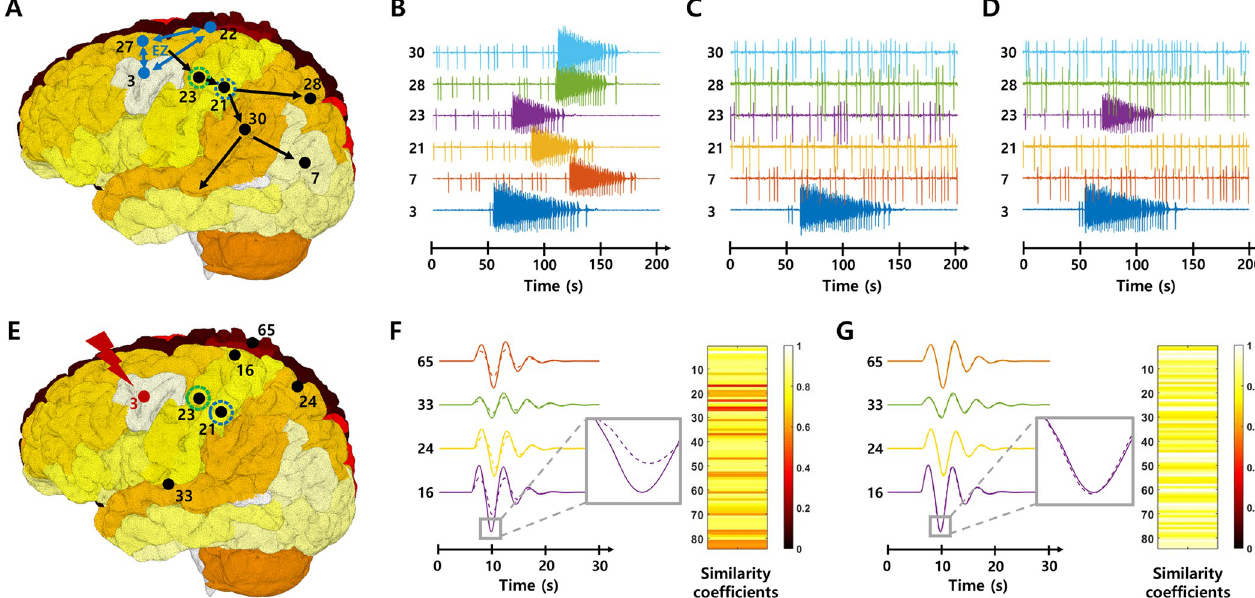
Fig 1. Brain network simulations using TVB. A-D Network simulations for the effectiveness evaluation. The brain network model assesses the effectiveness by identifying the seizure propagation characteristics. Figures show simulated signals at each brain node B before and C-D after removal of the node 23 or node 21 respectively, when nodes 3, 22 and 27 act as EZ. E-G network simulations for the safety evaluation. The brain network model assesses the safety by investigating the integrity of the transient spatiotemporal trajectory following electrical stimulation at certain nodes. When a stimulus is applied to the node 3, the stimulation induces different response signals at each node (solid lines, F-G ). When removing all connections from the node 23, the response signals (dotted lines, F ) at each node are altered compared to before removal. On the other hand, when eliminating the node 21, the response signals (dotted lines, G ) are not significantly different from that before removal. The color bars represent similarity coefficients between the response signals at each node before and after elimination.